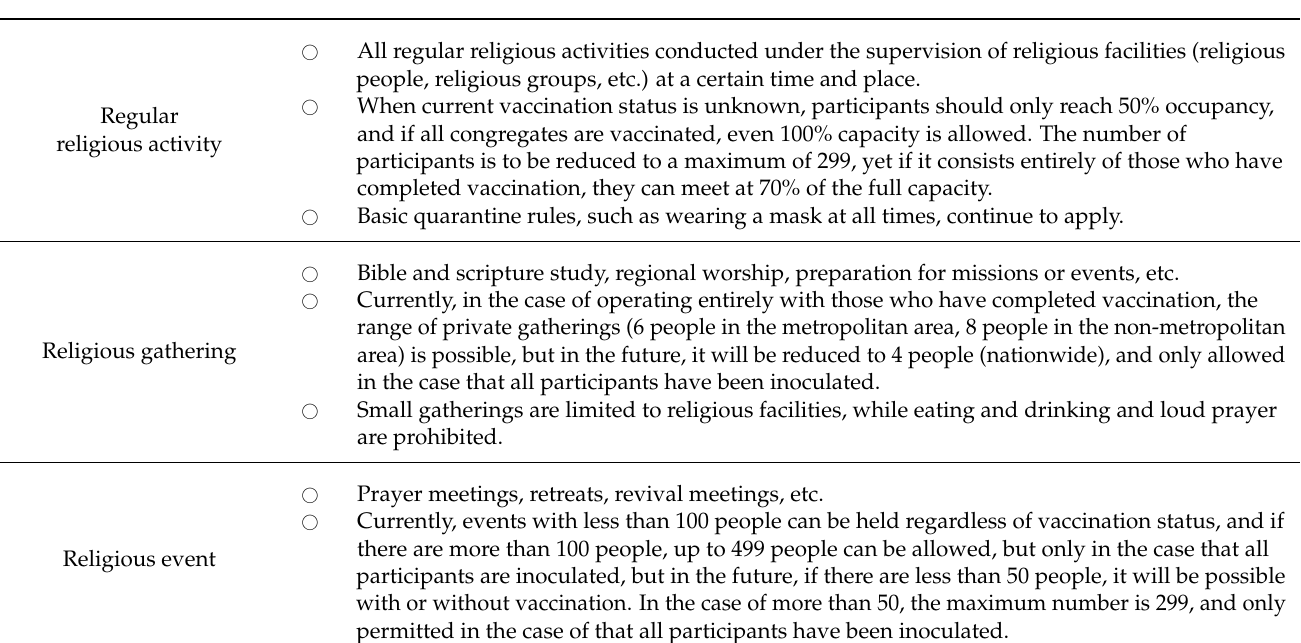
Table 2. Limiting the number of participants and strengthening quarantine rules (Ministry of Health and Welfare